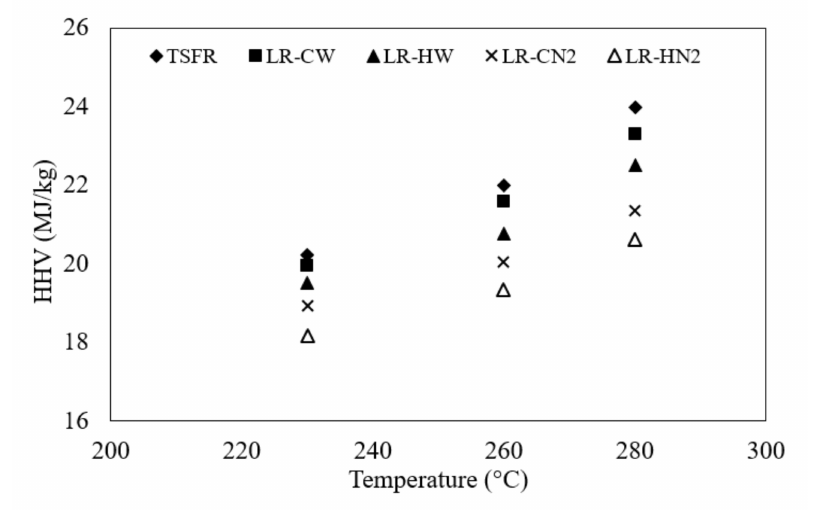
Figure 7. The relationship between the higher heating value (HHV) and torrefied temperature.